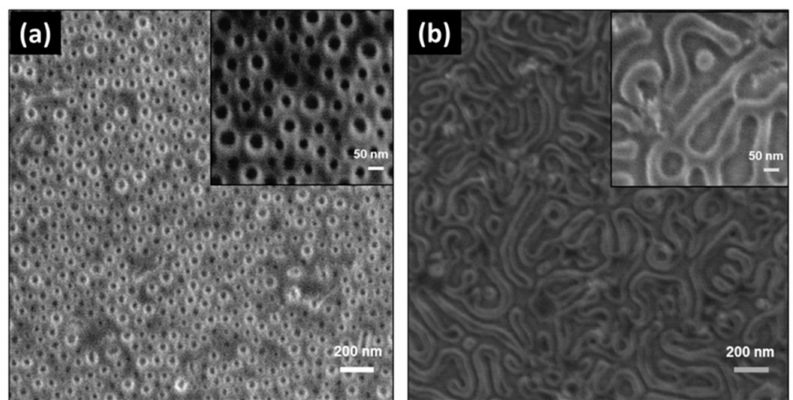
Figure 4. Top-down SEM images of P1 ( a ) and P 3 ( b ) after oxygen plasma